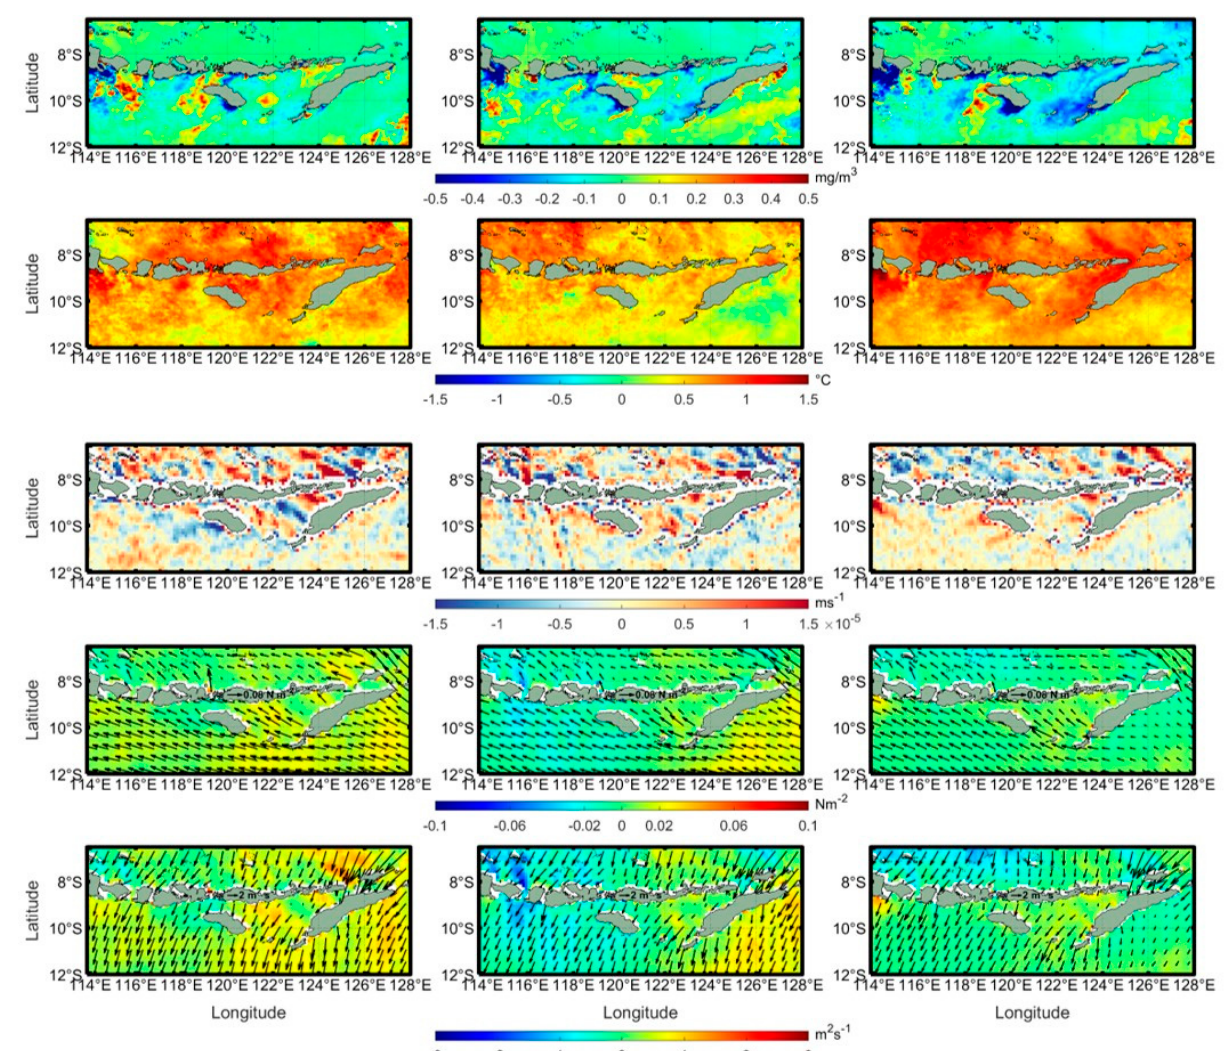
Figure 18. The anomalies of chlorophyll-a, sea surface temperature (SST), Ekman Pumping Velocity (EPV), wind stress, and Ekman Mass Transport (EMT) during the 2010 negative Indian Ocean Dipole (IOD) and La Nina (June–August from left to right), respectively (from top to bottom).